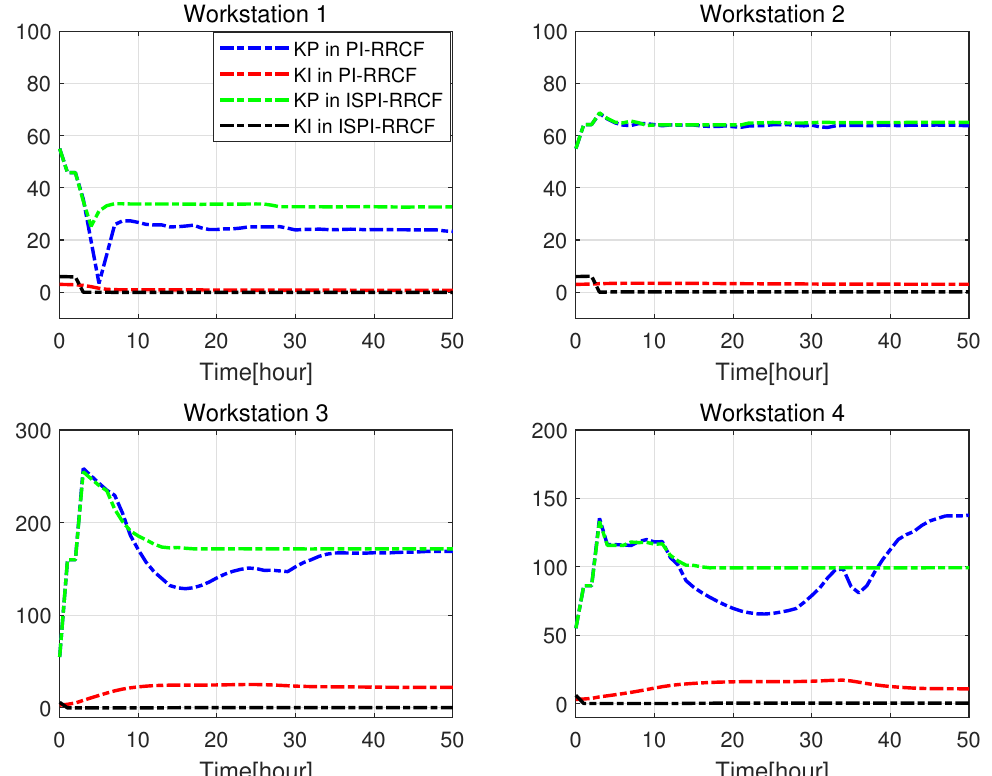
Figure 9. Value of the tracking controller’s parameters. Unlike the performance analysis in the workstations, the input and output rates of each product were not independent, which caused dynamic changes in the workstations’ productivity. When facing stochastic demands, the input rates of each product were the same in both control systems, as shown with the black lines in Figure 10. The blue and red lines represent the product output rates in the PI-RRCF and ISPI-RRCF control systems. Products 1, 2, and 3 were produced starting from the first, second, and first workstations and were finished at the third, fourth, and fourth workstations, respectively. The output rate of each product was produced by the DMTs at the beginning. With the additional RMTs assigned to the later two workstations, the output rates were quickly increased around the input rate in 20 h in the ISPI-RRCF system. However, the PI-RRCF system took a longer time. Additionally, the output rates in ISPI-RRCF were around the